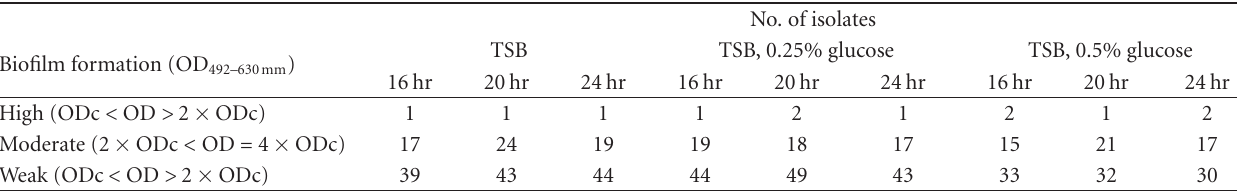
Table 3: Screening of 100 bacterial isolates for biofilm formation by microtitre plate method in di ff erent media and at 16, 20, and 24hr incubation periods.